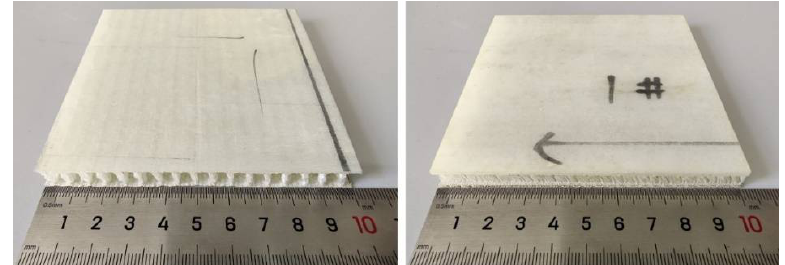
Figure 3. Drop weight impact test specimen.